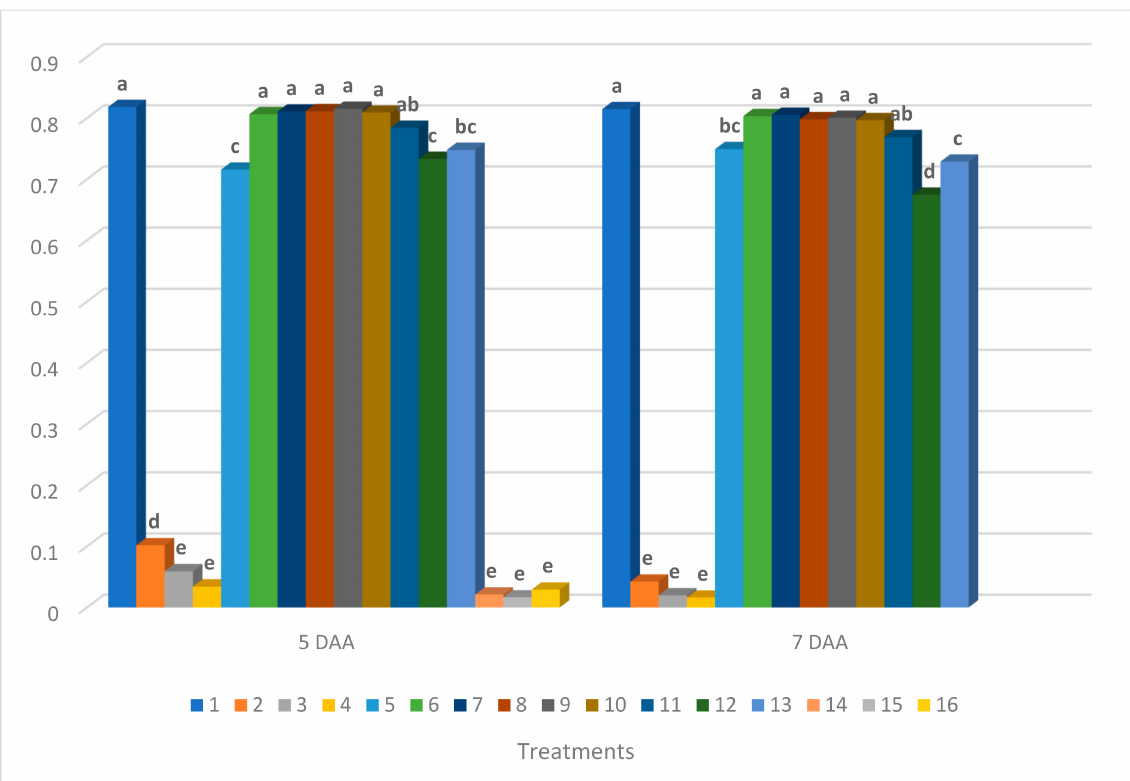
Figure 4. The effect of herbicides on Fv/Fm—maximum photochemical efficiency of PSII(non-nominated units). a–e different letters indicate statistically different mean LSD ( p < 0.05) 5 DAA = 0.04; LSD ( p < 0.05) 7 DAA = 0.03. (1—untreated; 2—16 herbicides applied at different pH of the spray solution: 2–4—mesotrione; 5–7—nicosulfuron; 8–10—rimsulfuron; 11–13—mesotrione + nicosulfuron + rimsulfuron + adjuvant; 14–16 bromoxynil; details description of treatments is included in Table